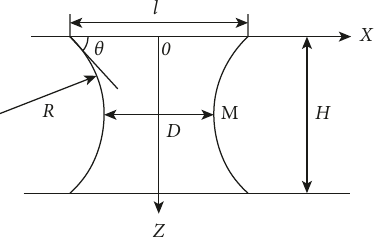
Figure 5: Schematic diagram of liquid bridge between two Table 1: Theoretical value of liquid bridge adhesion under different contact angles. Stretching distance, H (mm)